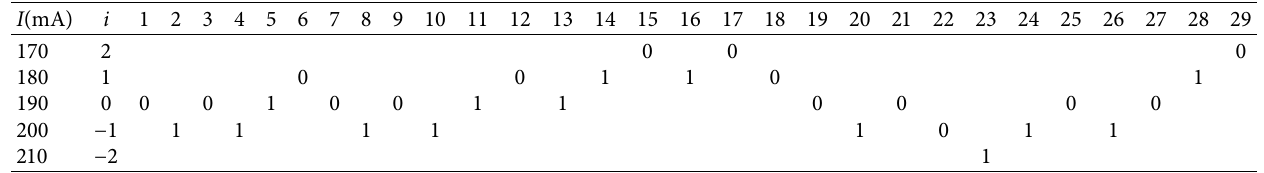
Table 1: Test data of ignition excitation of EED under stable